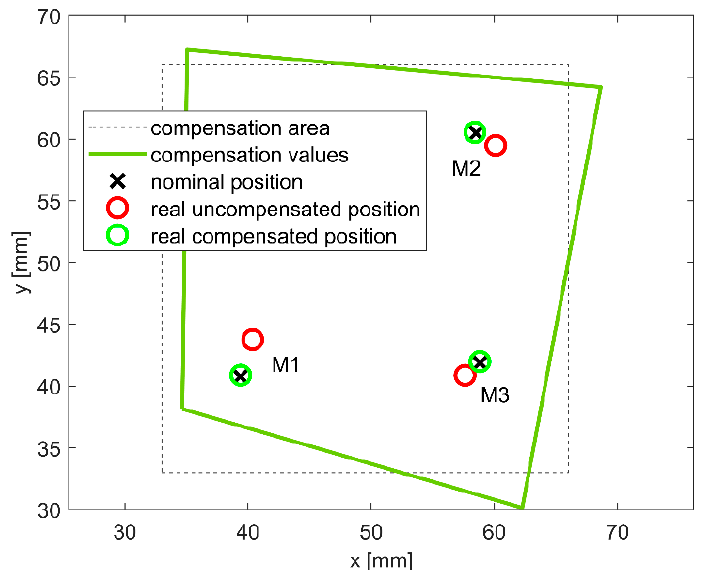
Figure 9. Nominal, real uncompensated and real compensated positions of measuring points in the Siemens Sinumerik 840D sl control system.